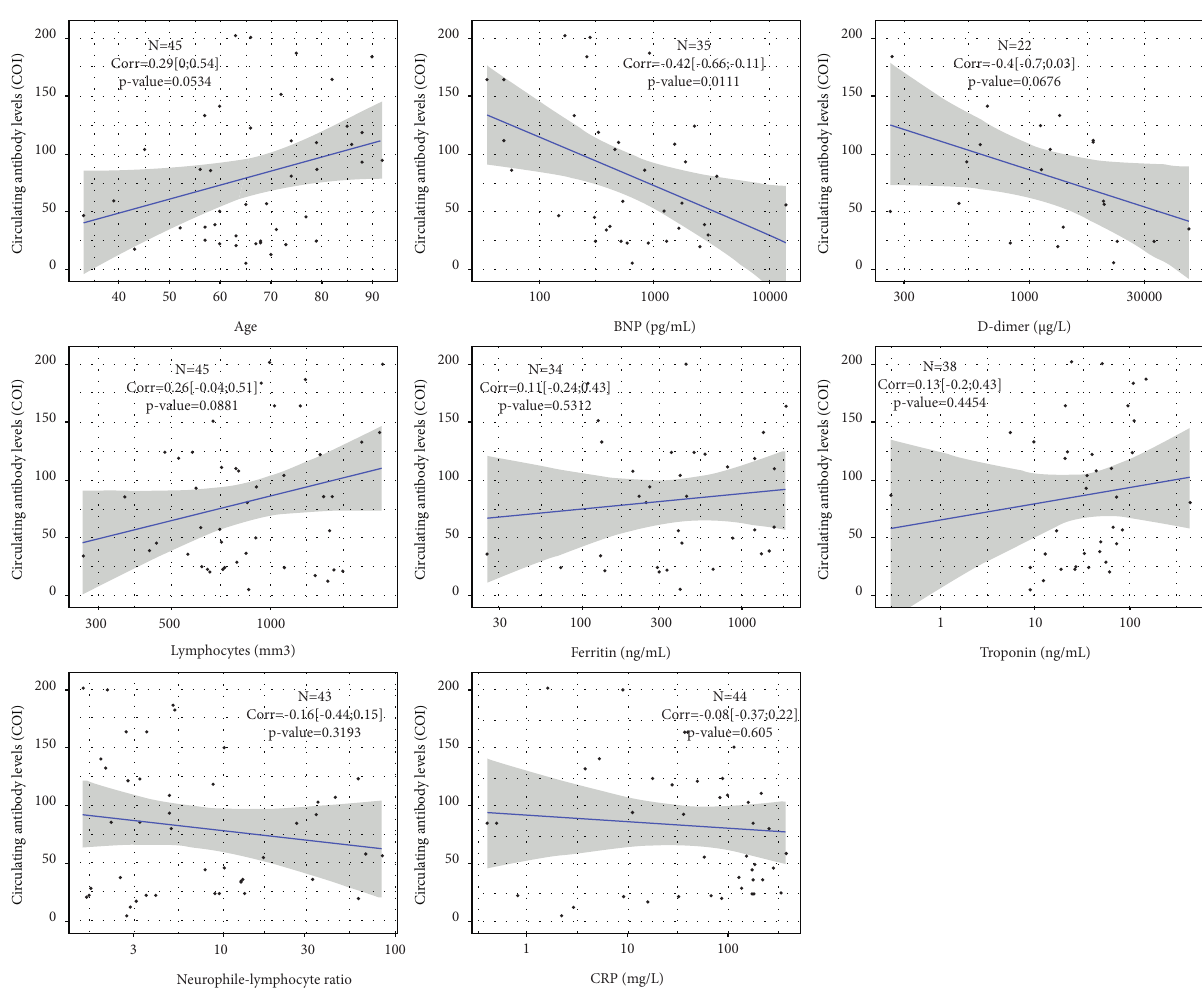
Figure 2: Values of Pearson correlation coefficient between the circulating levels of antibodies against SARS-CoV-2 and the different continuous variables (age and biological parameters) of the hemodialysis patients.